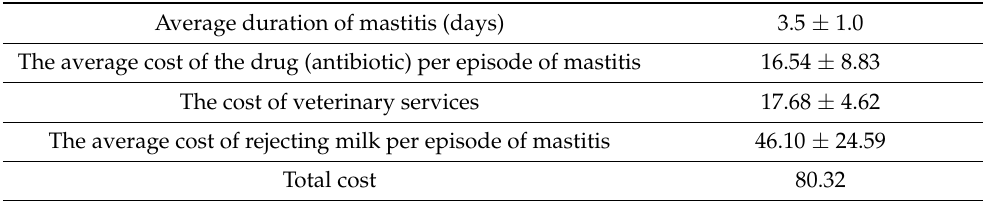
Table 3. Total cost of mastitis in the analyzed sample of 100 cows expressed in euros (EUR) (average ± SD).